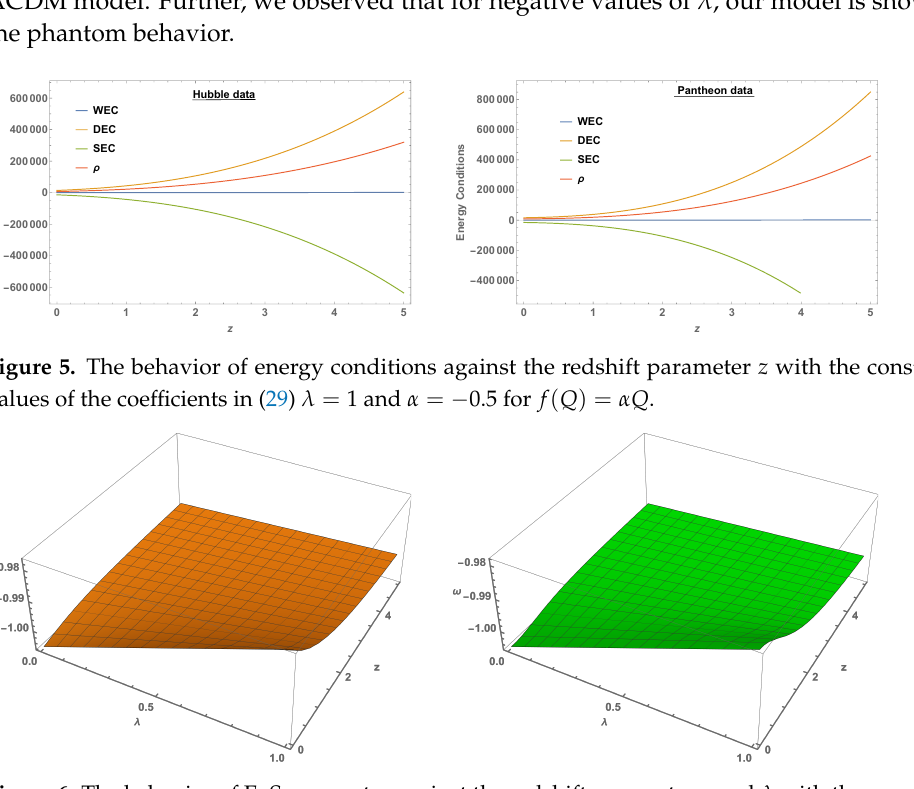
Figure 6. The behavior of EoS parameter against the redshift parameter z and λ with the constraint values of the coefficients in (29) and α = − 0.5 for f ( Q ) = α Q . Left side graph for Hubble data and right side graph for Pantheon